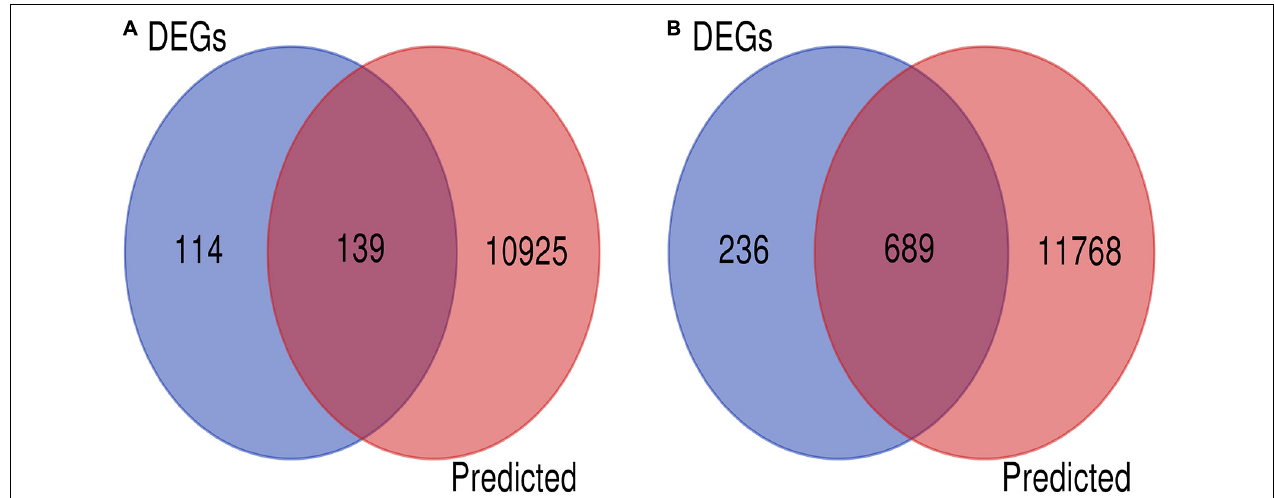
FIGURE 3 | Screening of candidate genes. (A) Intersection of target genes of upregulated mRNAs (blue) and downregulated miRNAs (pink). (B) Intersection of downregulated mRNA (blue) and target genes of upregulated miRNAs